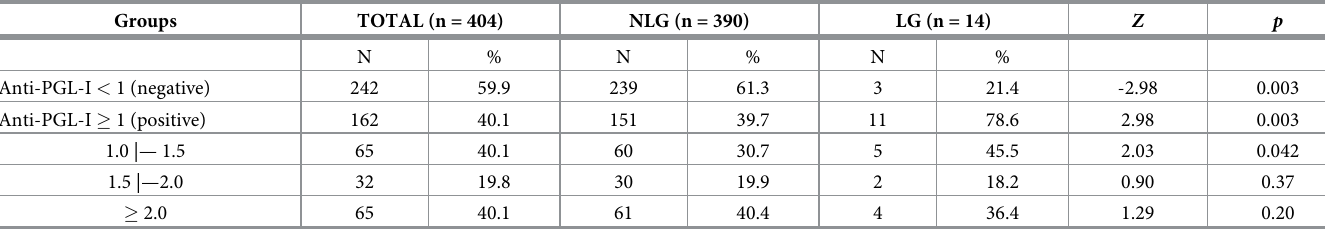
Table 5. Distribution of anti-PGL-I antibody ELISA index among individuals of Non-Leprosy group (NLG) and Leprosy Group (LG).